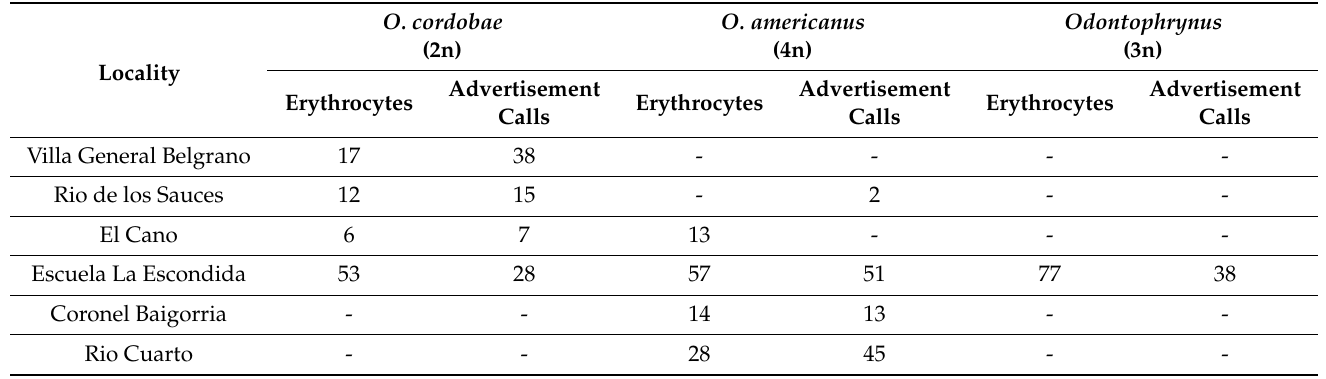
Table 2. Frequency of Odontophrynus taxa at the study localities. The number of males and females collected for ploidy determination (erythrocyte/nuclear size) and that of males recorded during ad- vertisement is given. Note that not all males recorded calling were captured for ploidy determination and vice